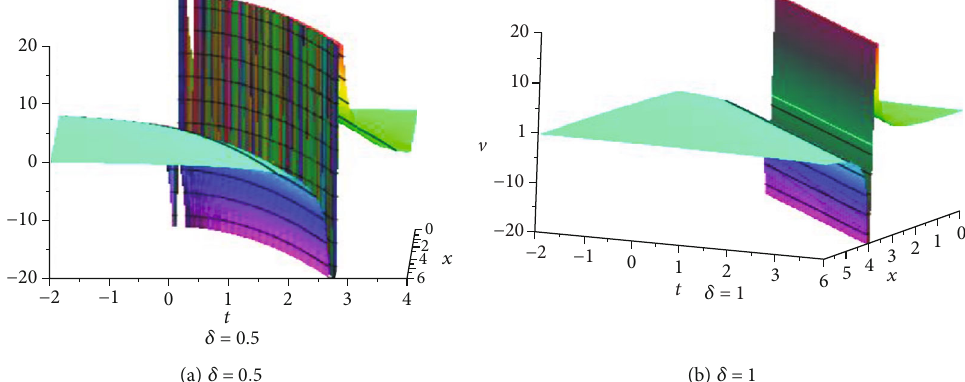
Figure 2: Topological singular kink wave for l = k = q = m complete order.